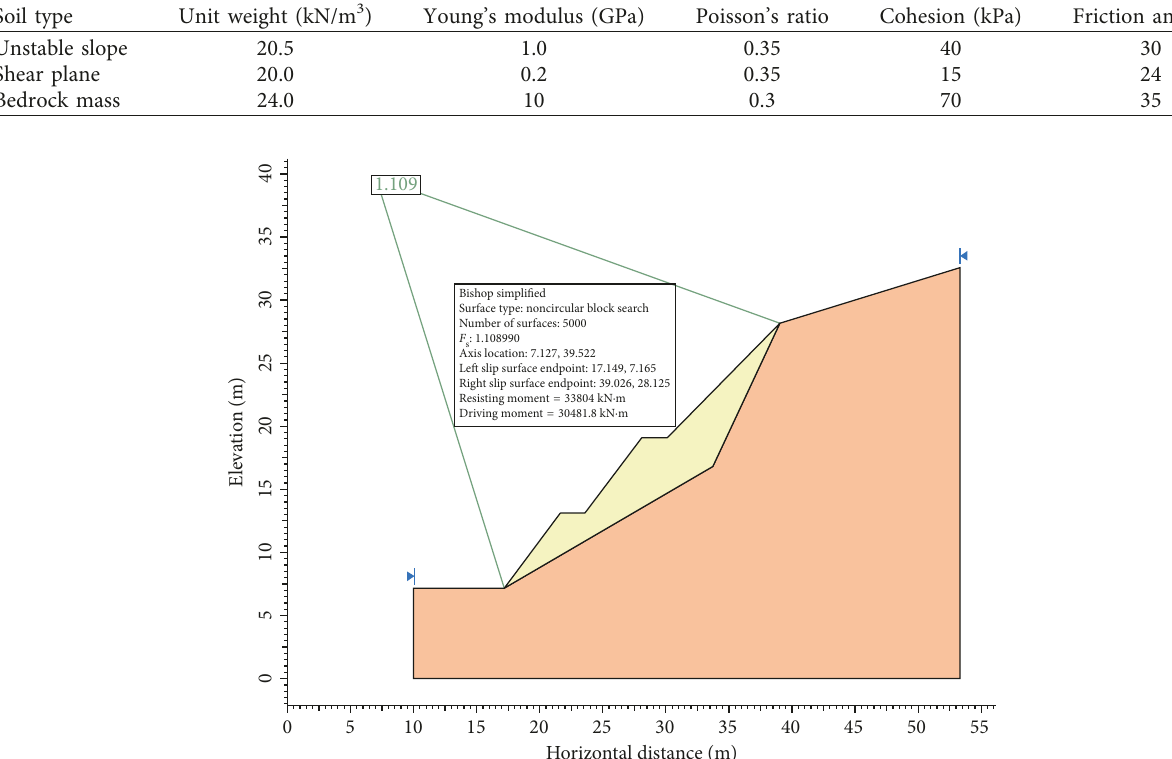
Figure 2: Limit equilibrium result using the Bishop method of the verification model.